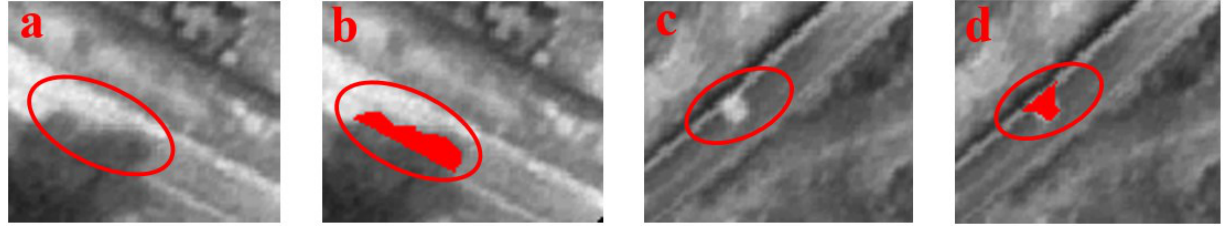
Figure 10. Results of damage detection. Red regions are the damaged road segments.